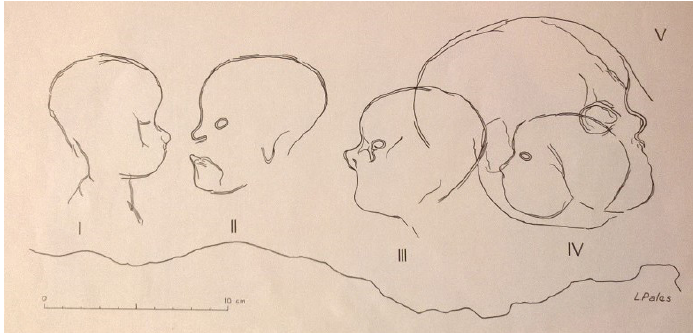
Figure 13. Group α, examples of Hand α4: Obs. 27(I-V) (from Pales, 1976).